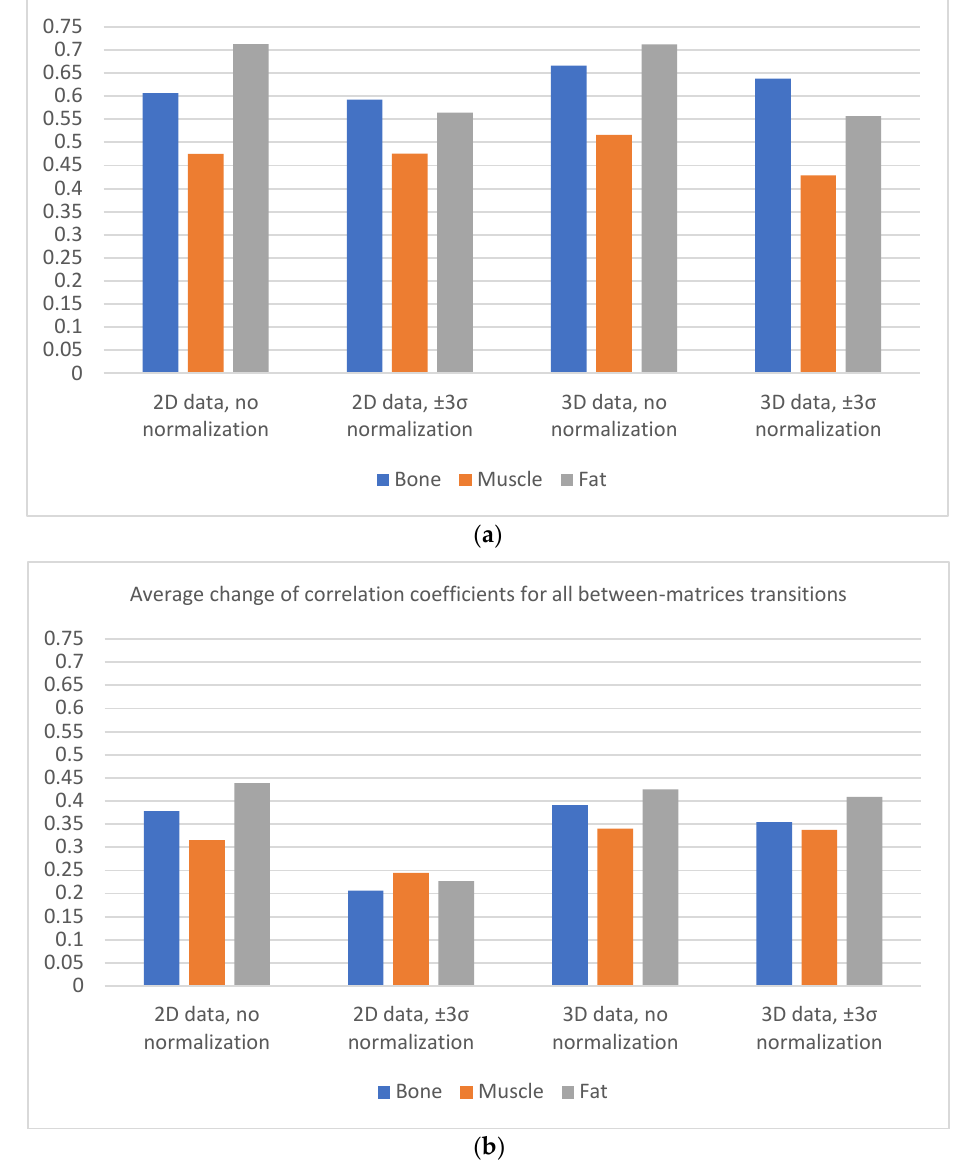
Figure 9. ( a ) Values of correlation coefficients averaged at all transitions between matrices; ( b ) mean change of correlation coefficients at all transitions between the matrices.